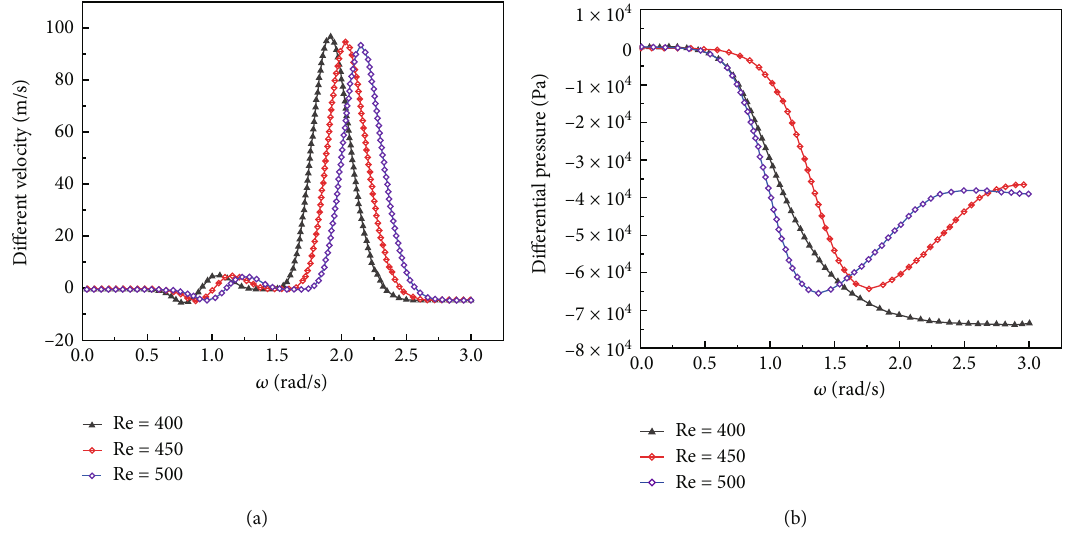
Figure 7: Distribution of the oscillating fl ow fi eld in variable cross-section pipeline at a certain